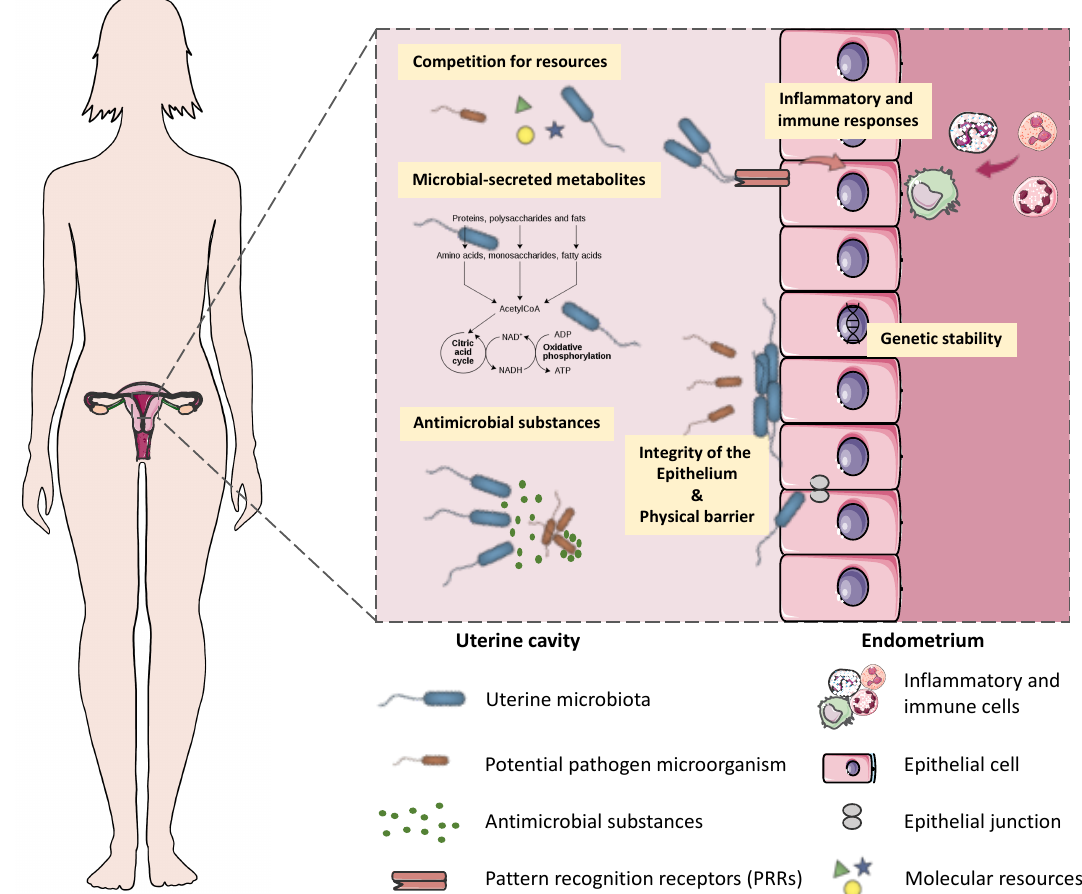
Figure 2. Endometrial microbiota interplay in the uterus. Uterine microbes could impact the genomic stability of uterine epithelia through modulation of transcription factors and other genomic and epigenetic alterations; also, microbial-secreted metabolites may support the growth of specific species and suppress the growth of other bacteria; and the consumption of a limited resource can starve the pathogenic invaders. In short, the endometrium is an immunologically suited niche for microbes: the endometrial immune system needs to be well adapted to withstand the continuous threat caused by microbial colonisation of the large endometrial mucosal surface, separated from host tissue by only a single layer of epithelial cells. Thus, tissue invasion of microbes must be limited in order to prevent potentially harmful inflammation or imbalance in the symbiotic relationship. Endometrial microbial homeostasis is probably regulated in three di ff erent ways: (1) a single layer of columnar epithelial cells forming a strong barrier through tight junctions anatomically limiting exposure of resident bacteria to the systemic immune system; (2) immune mediators such as infection-controlling molecules (antimicrobial peptides, AMPs) that are present in the endometrial mucosal surface and the endometrial fluid [99] and could restrict direct contact between epithelia and microbes; and (3) a rapid detection (epithelial cells express pattern recognition receptors (PRRs) that recognise and act to pathogens) and killing of bacteria upon a barrier breach by the endometrial lymphocytes that are present throughout all stages of the menstrual cycle